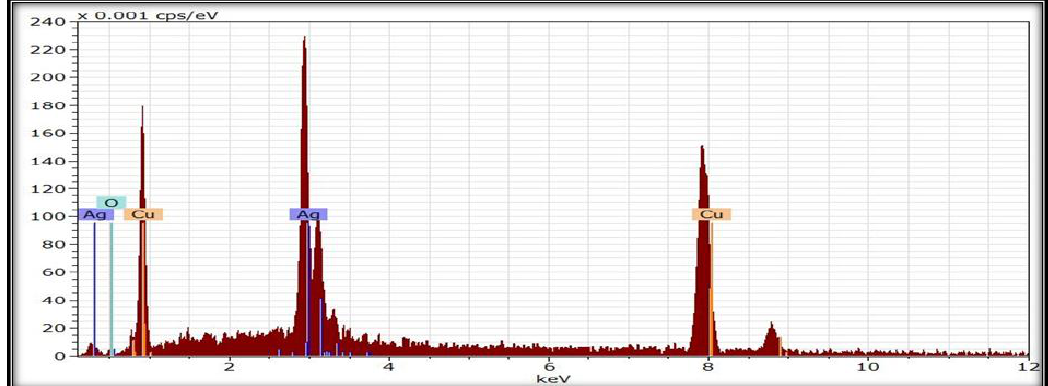
Fig.1: EDS chart of Ag